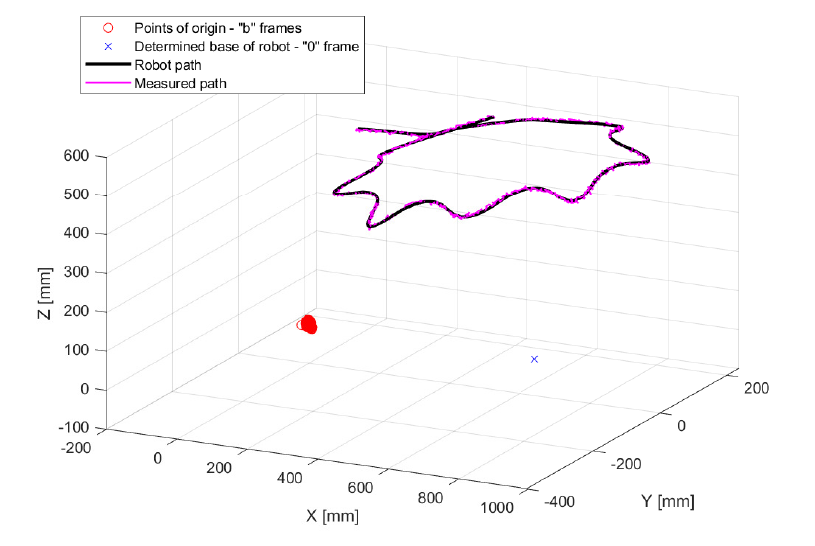
Figure 10. Path measured by a camera in comparison with the real robot path of experiment B.